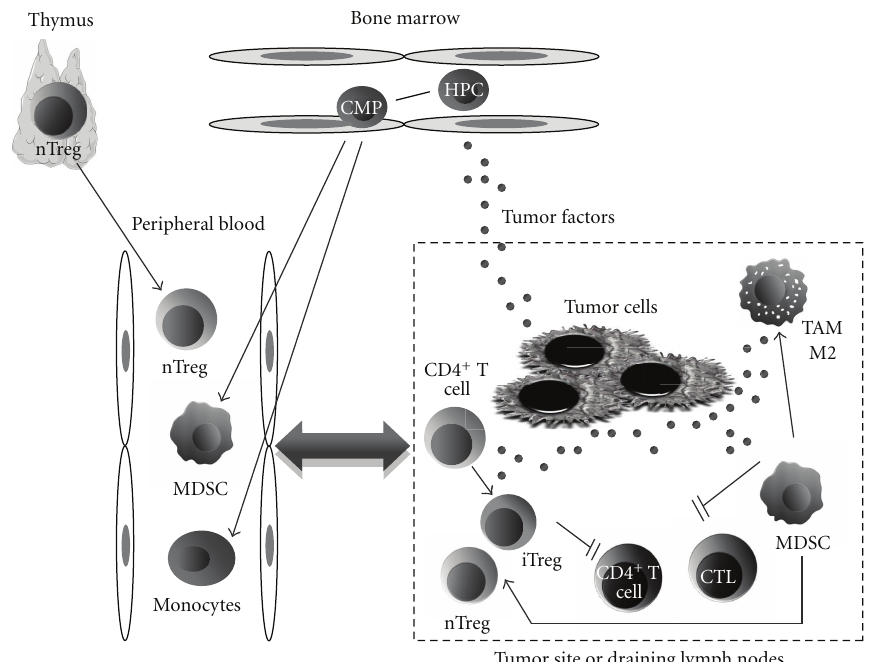
Figure 1: Schematic representation of the potential role of the immune suppressive cells (ISCs) in cancer. The release into the circulation of ISCs derived from thymus (nTregs) or from bone marrow (MDSCs) is partially driven by factors secreted by the tumor. Successively, ISCs can migrate into the tumor site (or a draining lymph node). Moreover, several factors produced in the tumor microenvironment may induce the conversion of CD4 + T cells into iTregs or drive the polarization of monocytes towards a M2-phenotype. All these phenomena lead to an inhibition of CD4 + T-helper cells and cytotoxic T lymphocytes (e ff ector cells), resulting in a general decrease of the antitumor immune response. Theoretically, the release of ISCs from the thymus, the bone marrow, and the tumor site to the peripheral blood could reflect the immunosuppressive status of the antitumor immune response and could be of use in the real time immune monitoring of patients enrolled in therapeutic vaccine clinical trials. HPC: hematopoietic progenitor cells; CMP: committed myeloid progenitors; nTreg: thymic-derived, naturally occurring regulatory T cells; iTreg: induced or adaptive regulatory T cells; MDSC: myeloid-derived suppressor cells; TAM-M2: tumor-associated macrophages characterized by M2-polarization; CTL: cytotoxic T